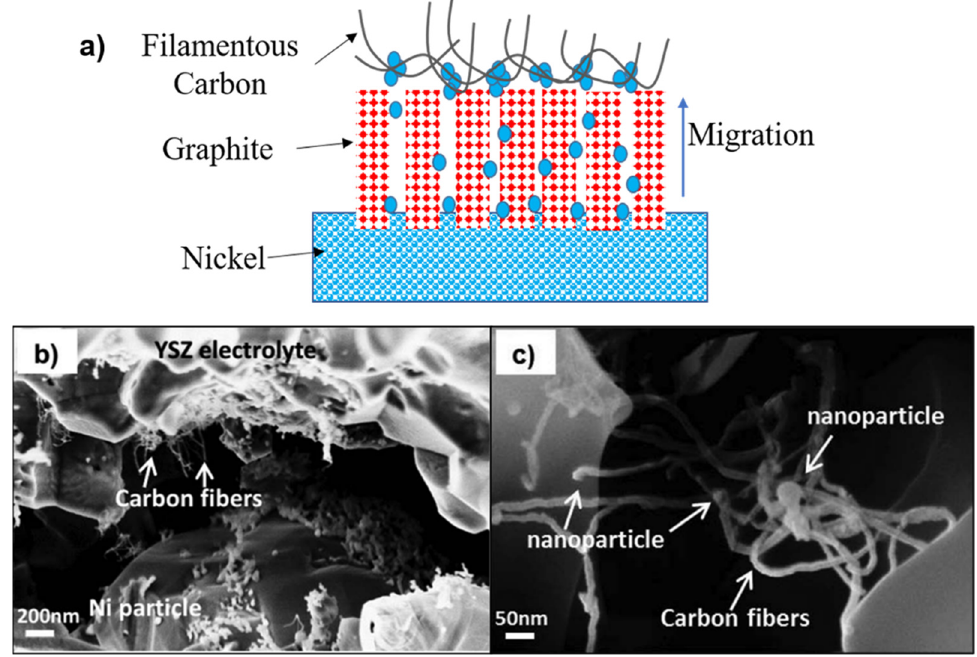
Figure 9. ( a ) Schematic representation of the mechanism of metal dusting corrosion of nickel, adapted from Ref. [43]. ( b ) The interface between the Ni particle (lower part) and the YSZ electrolyte (upper part) close to the gas inlet area of the cell and ( c ) showing the carbon nanofibers and nanoparticles at the Ni-YSZ|YSZ interface, reproduced with permission from Ref. [96].